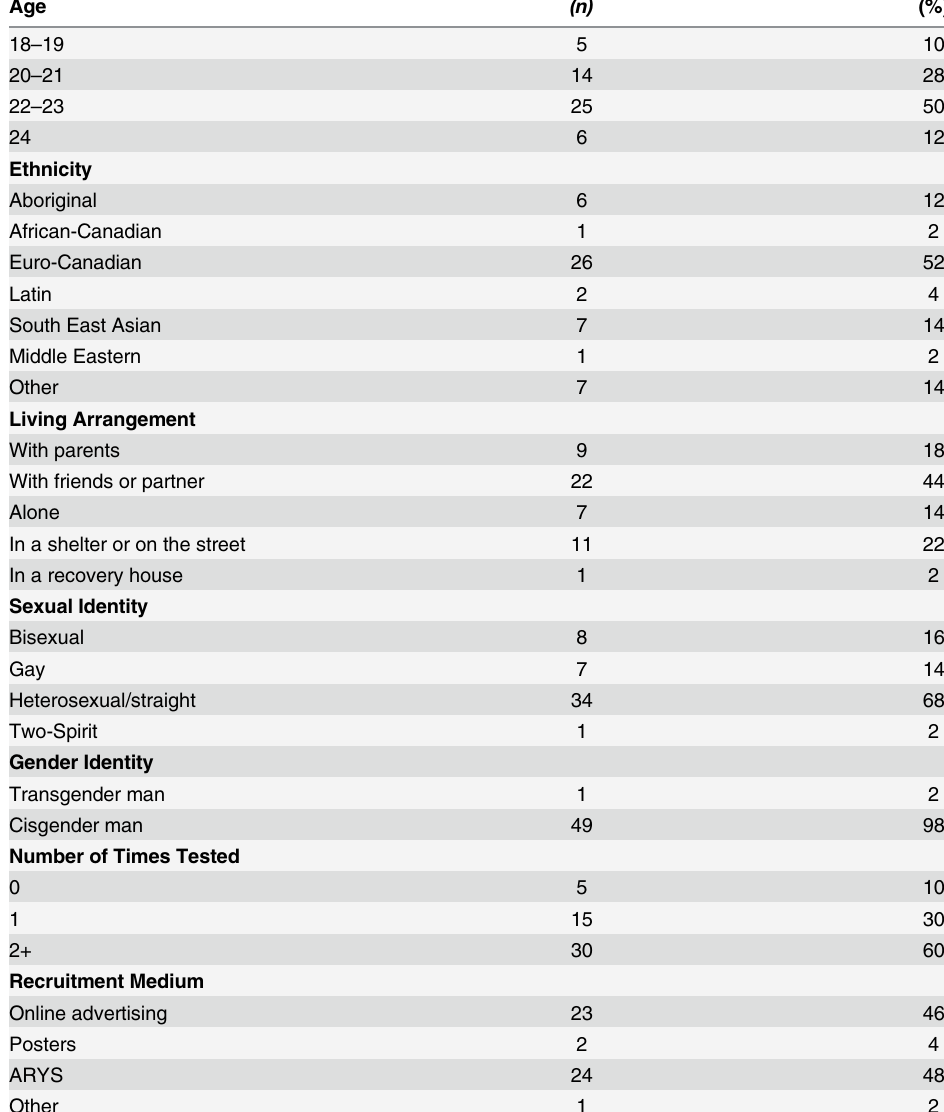
Table 1. Socio-demographic characteristics of study